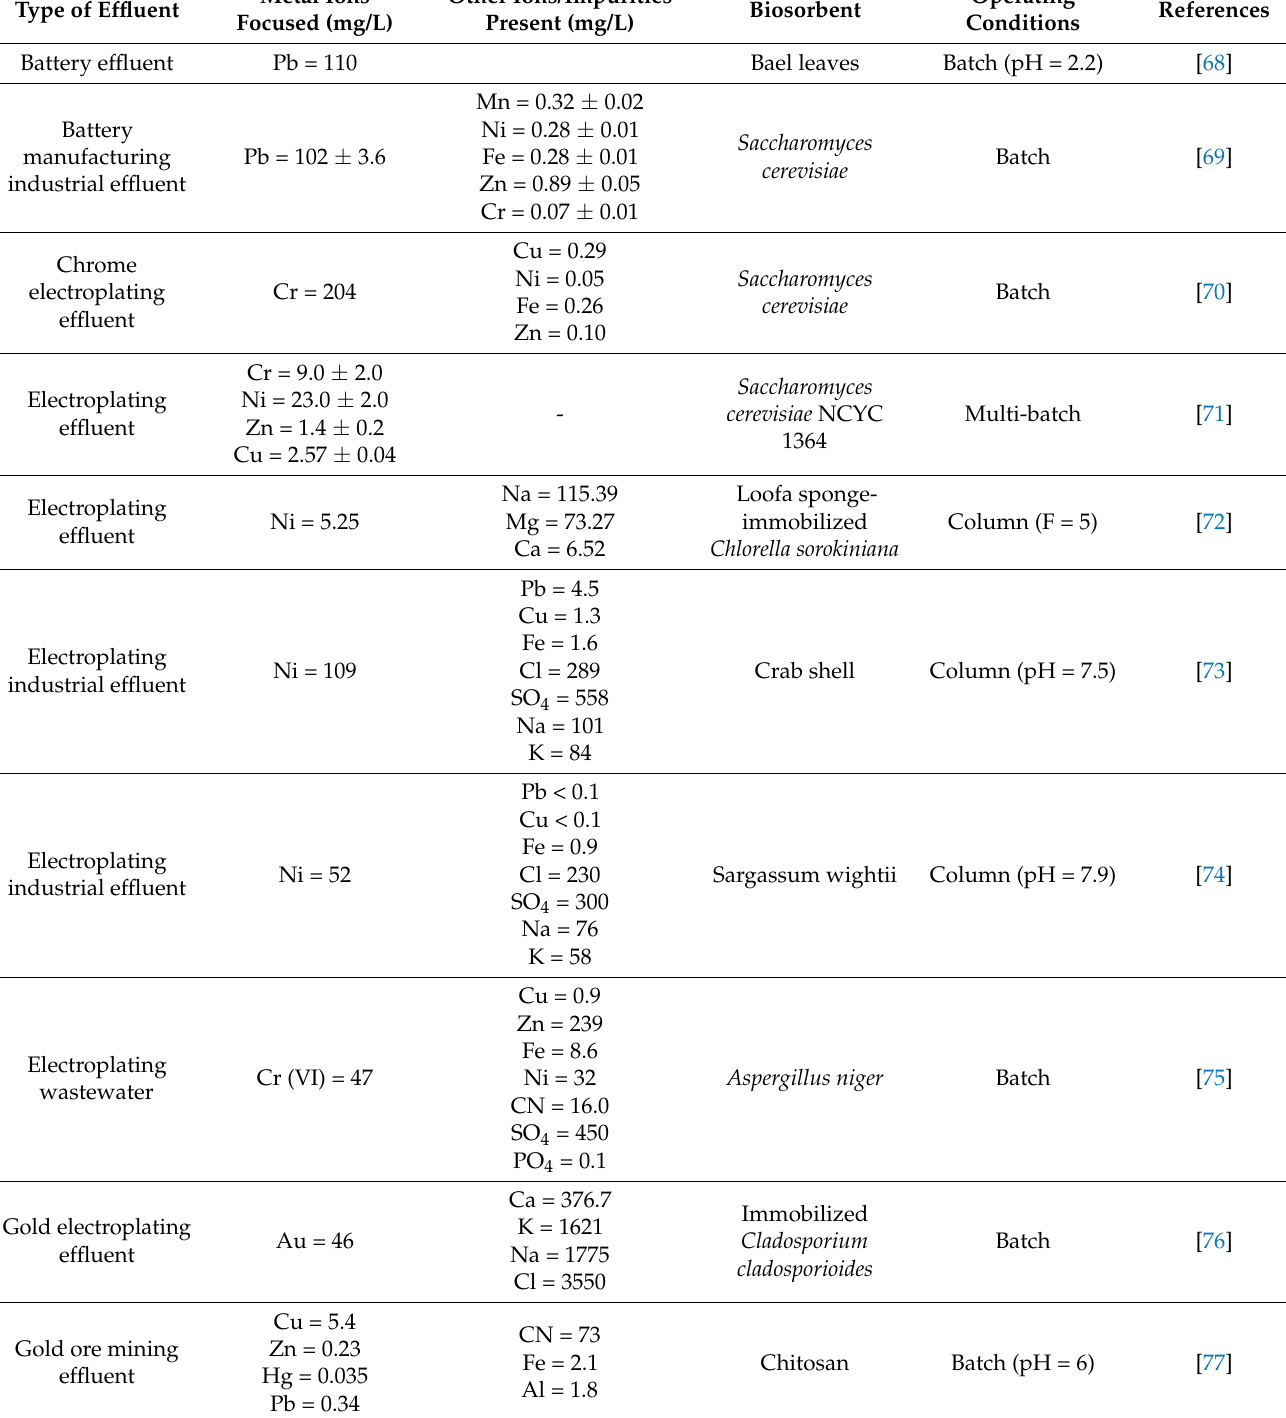
Table 2. Treatment of industrial effluents using the biosorption